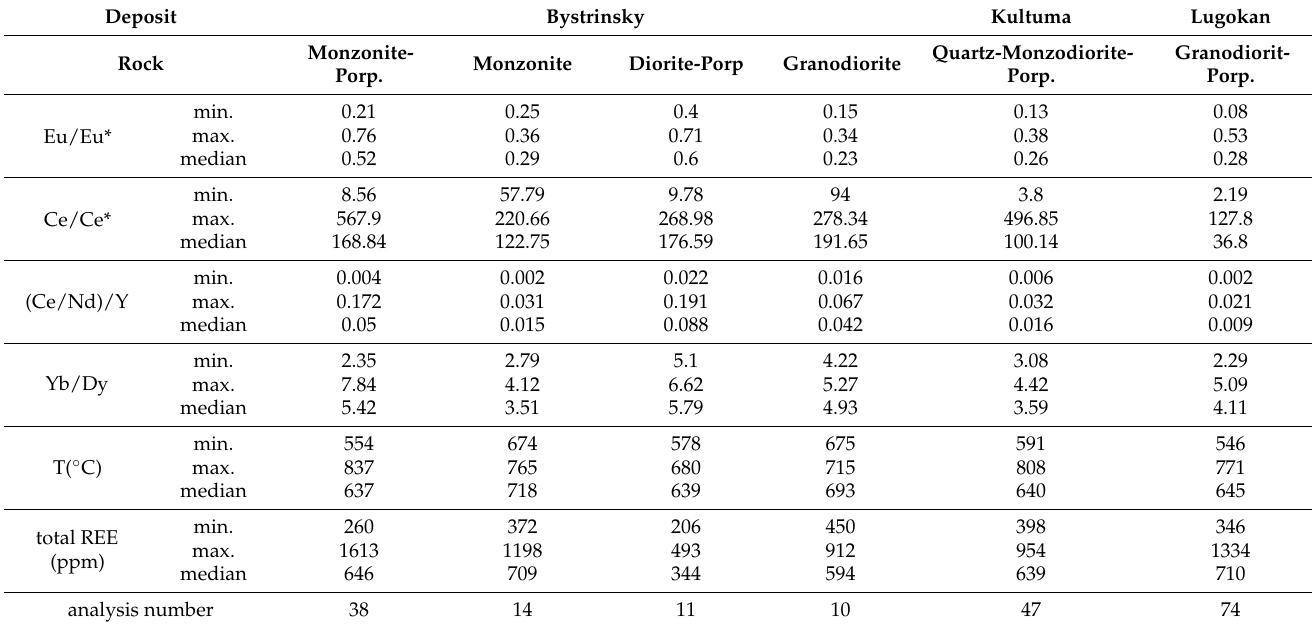
Table 2. The main characteristics obtained from the zircon